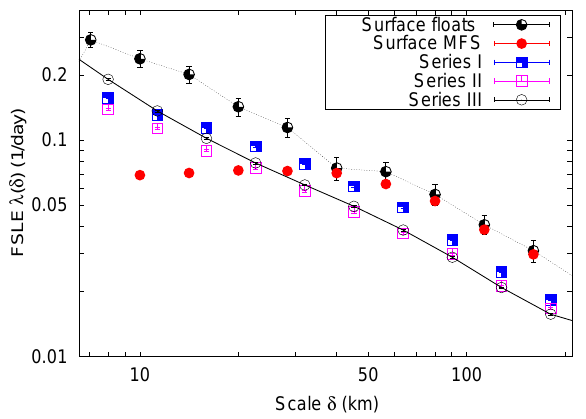
Figure 5. (Colour online.) Log-log plot of the finite-scale Lyapunov exponent λ(δ) versus the separation scale δ ; black filled circles: sur- face drifters; red filled circles: MFS surface particles (both after La- corata et al., 2014); blue filled squares: Series I, that is the MFS model for particle pairs at fixed depths; purple empty squares: Se- ries II, that is the MFS model plus the 3-D KLM; black empty cir- cles with solid line: Series III, as Series II plus the 2-D KLM. Error bars, often smaller than the symbols themselves, are estimated from the standard deviation of the